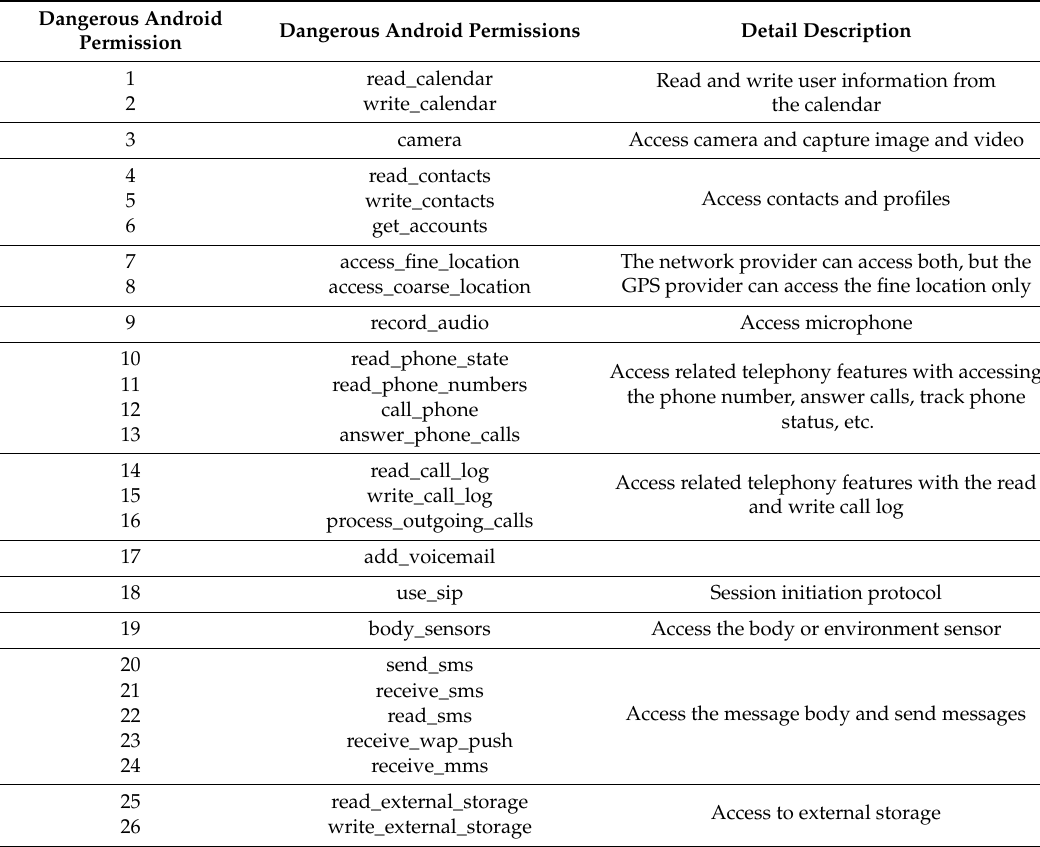
Table 4. Detail description of dangerous Android permissions, reproduced with permission from [59], Google Developers,